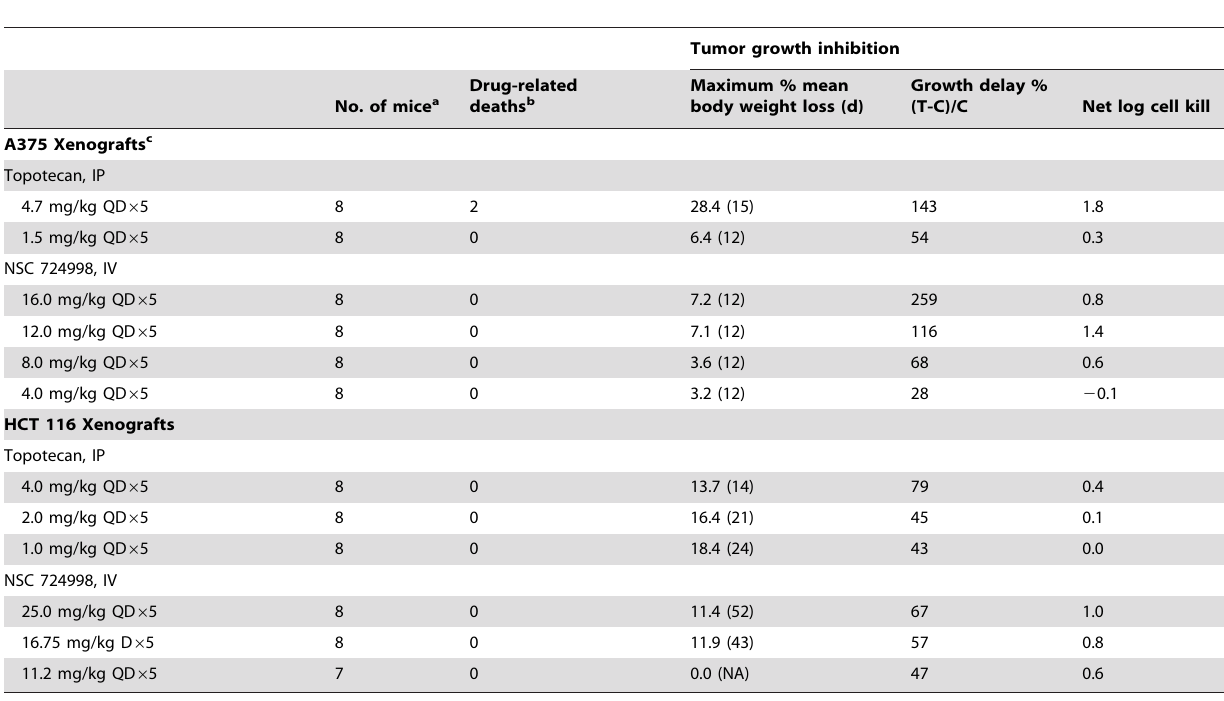
Table 3. Tumor response and biomarkers for Top1 inhibitors in topotecan-responsive xenograft models.